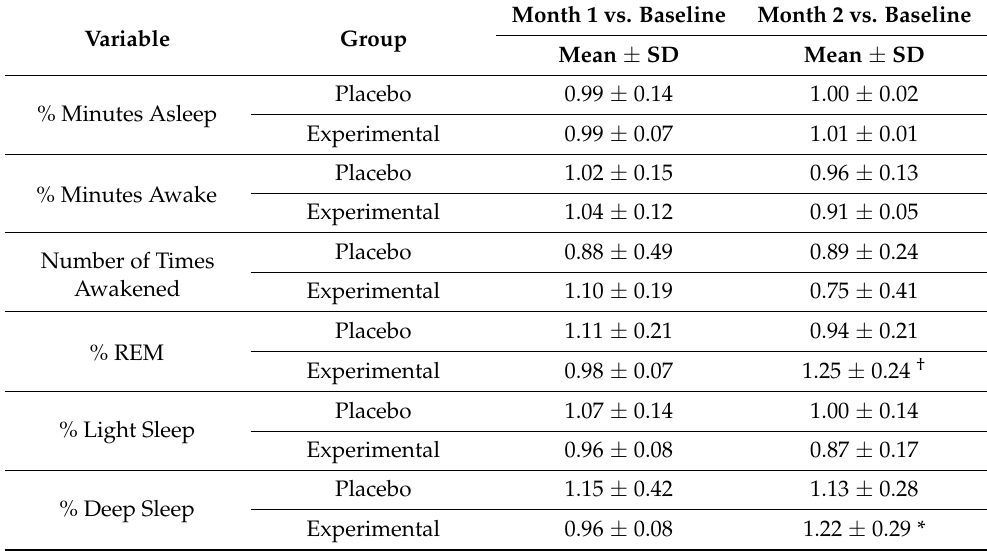
Table 11. Fitbit values in women population. change vs. baseline = percent change from